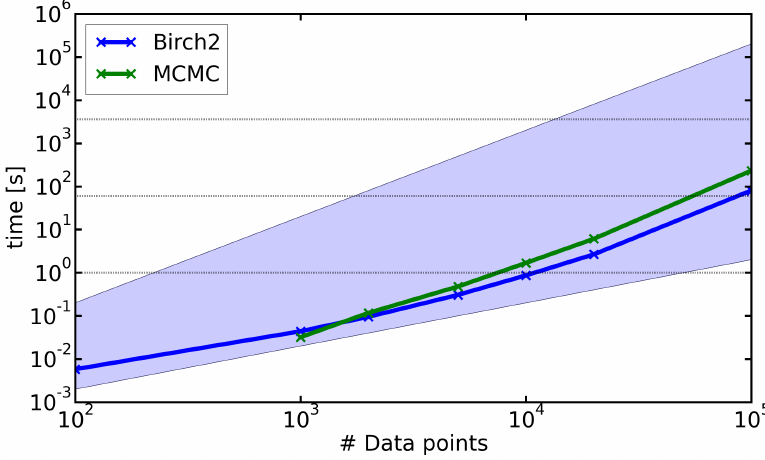
Figure 9. Run-time of the clustering step (without calculation of the distance matrix) for different dataset sizes for the ( blue ) Birch2 and ( green ) sample of the two-dimensional Boltzmann distribution (Section 4.2). The blue area highlights the scaling of the clustering step between linear (lower bound) and quadratic (upper bound) behavior. The dashed lines represent 1 h, 1 min and 1 s respectively. All calculations were performed on an Intel(R) Core(TM) i5-4590 CPU with 3.30 GHz and 16 GB of